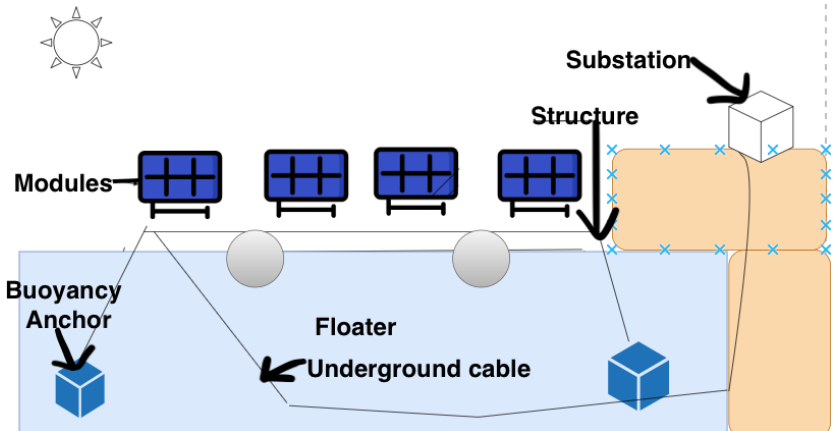
Figure 4. Components of a FSPVS.